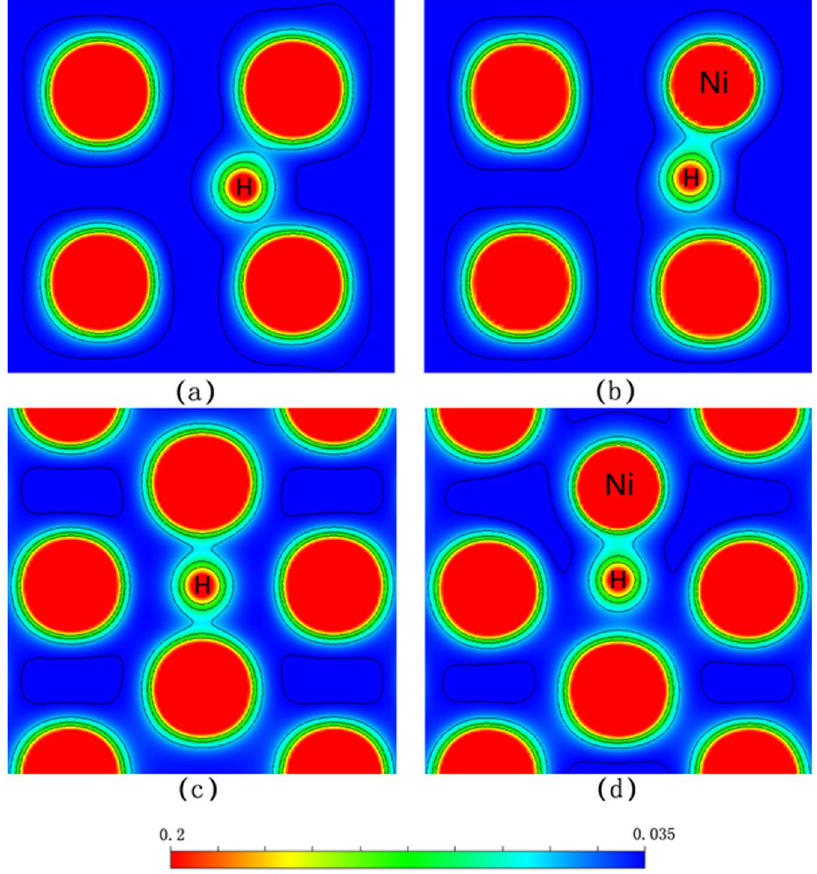
Figure 6. Charge density distribution of Nb 16 H and Nb 15 NiH with H at TIS site ( a , b ), H and at OIS site ( c , d